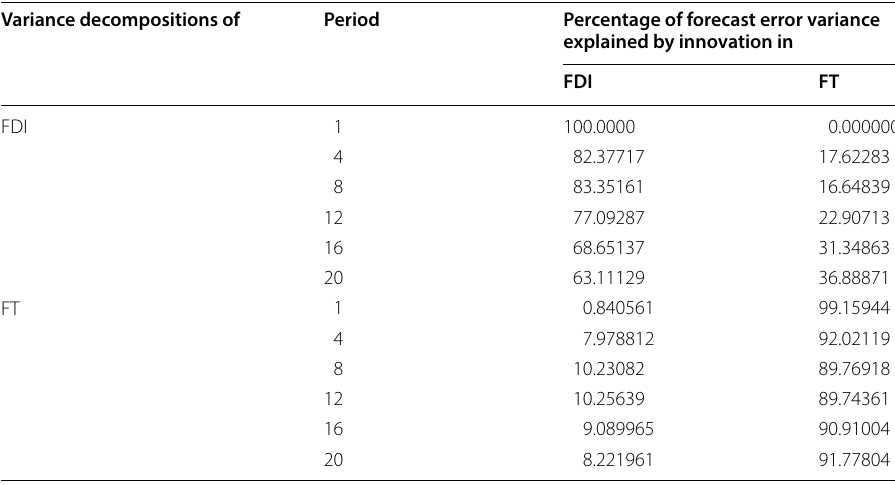
Table 10 Variance decomposition of FT and FDI. Source: Calculated by authors Variance decompositions